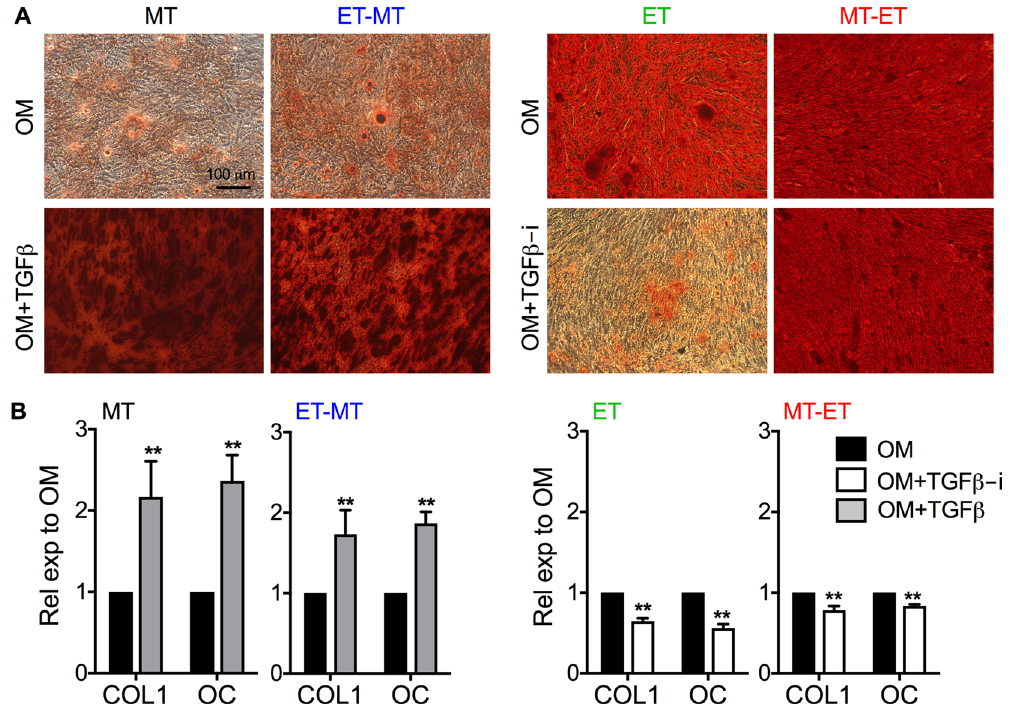
Figure 6. TGF β -dependent modulation of RS-hAFSC osteogenic differentiation. ( A ) The media of passage 16 RS-hAFSCs cultured in different conditions was replaced by osteogenic medium (OM) for 3 weeks. Alternatively, the media of passage 10 RS-hAFSCs cultured in MT or ET-MT conditions was supplemented with TGF β for 10 days before being replaced by osteogenic medium (OM + TGF β ) for 3 weeks and the media of passage 10 RS-hAFSCs cultured in ET or MT-ET conditions was supplemented with a TGF β inhibitor (OM + TGF β -i) for 48 h before being replaced by osteogenic medium (OM) for 3 weeks. The cultures were subsequently stained with Alizarin red to visualize areas of calcium deposition. ( B ) qRT-PCR for the osteogenic genes collagen type I ( COL ) and osteoclacin ( OC ), normalized to their expression in RS-hAFSCs cultured under MT conditions. GAPDH was used as internal